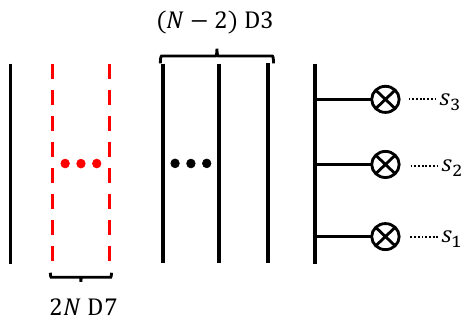
Figure 10 . A brane con(cid:12)guration for the ’t Hooft operator with the magnetic charge B = 3 e N .